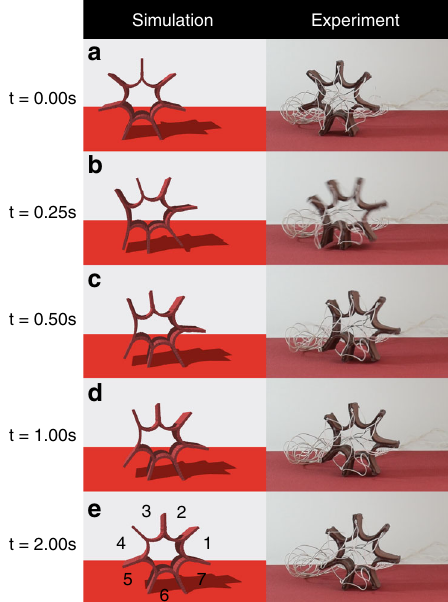
Fig. 4 Snapshots of rolling robot. a – e Snapshots of rolling robot from simulations and experiments between t = 0.0 s and t = 2.0 s. Limb #4 is actuated for a rolling motion. The width (out-of-plane dimension in this fi gure) is 18